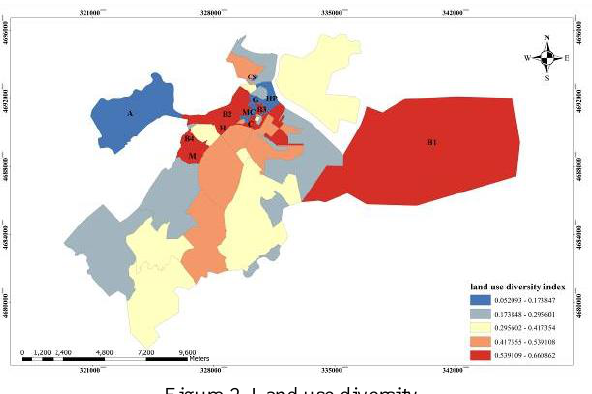
Figure 2. Land use diversity